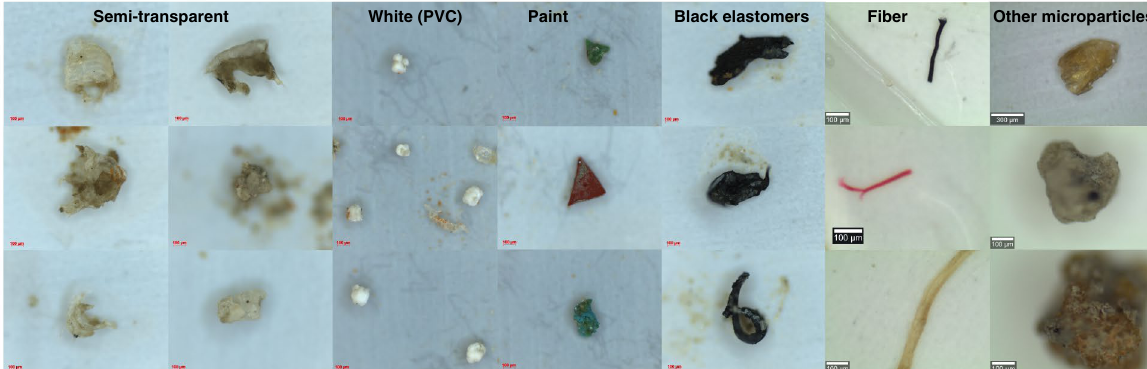
Figure 2. Categories of typical particles, semi-transparent plastic particles, white (PVC particles), paint particles, black elastomers, synthetic fibers, and other anthropogenic